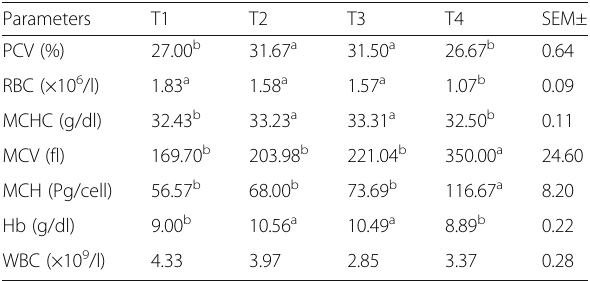
Table 6 Hematological parameters of broiler fed fungi treated cocoa pod husk meal Parameters